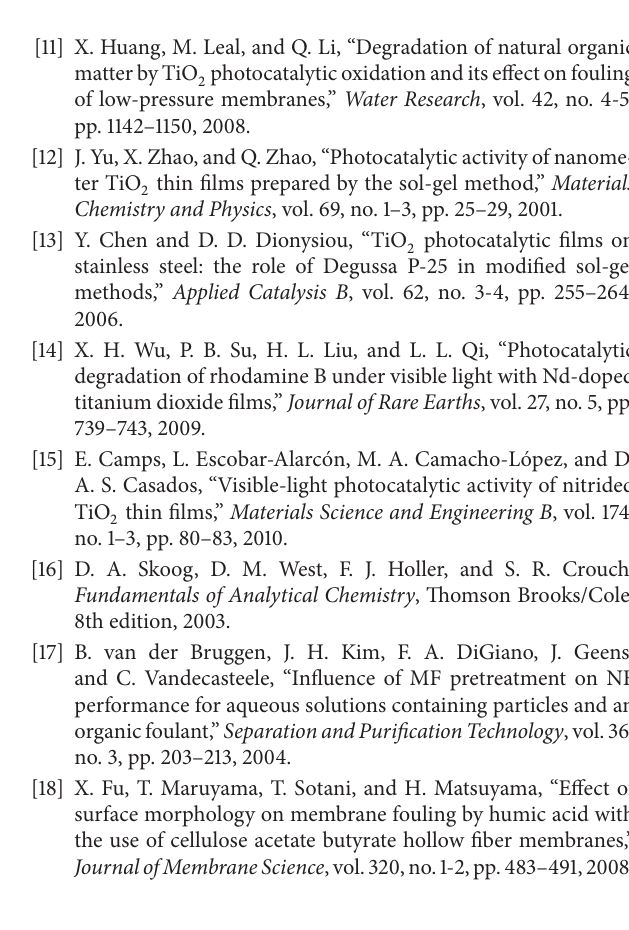
Table 1: Permeate quality after being treated by TiO Raw water